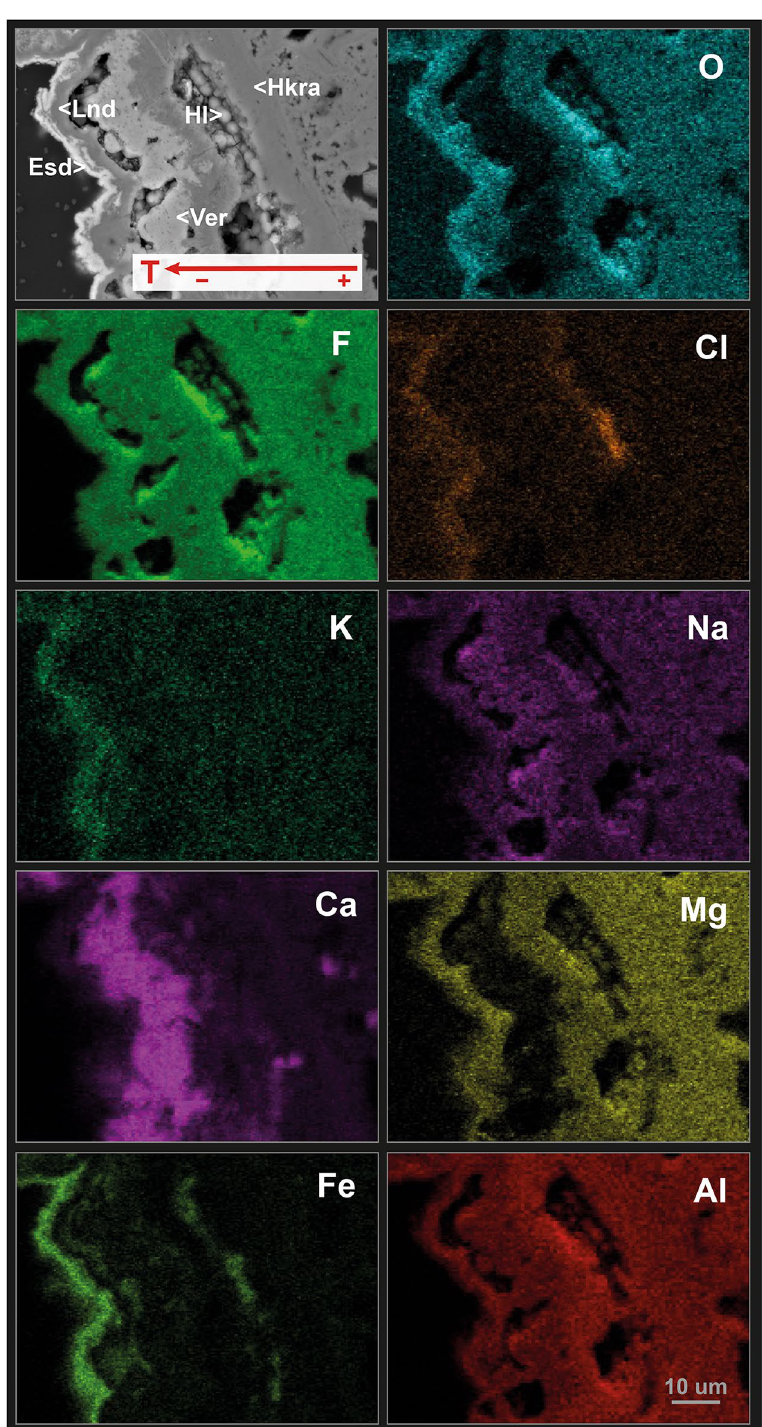
Figure 7. Wavelength-dispersive X-ray maps of representative elements of the typical fluoride-chloride assemblage from the Tajogaite proximal fumaroles: erytrosiderite (Esd) leonardsenite (Lnd), verneite (Ver), halite (Hl) and hydrokenoralstonite